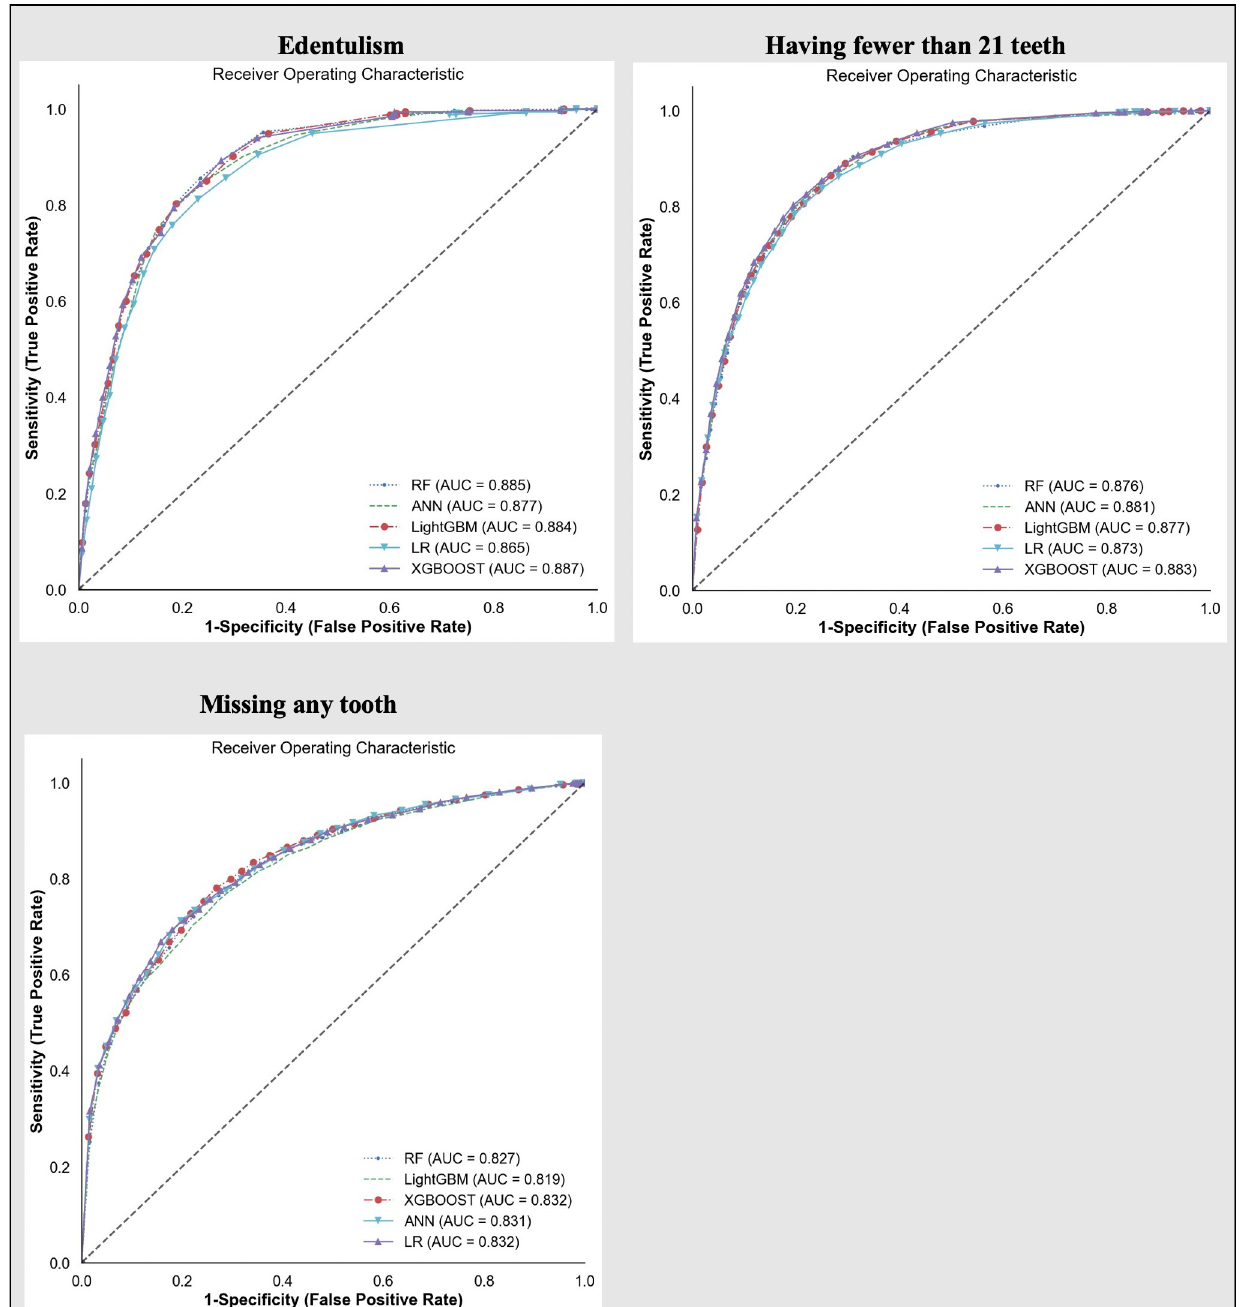
Fig 2. Receiver-operating characteristics curves for the five analyzed predictive models for each